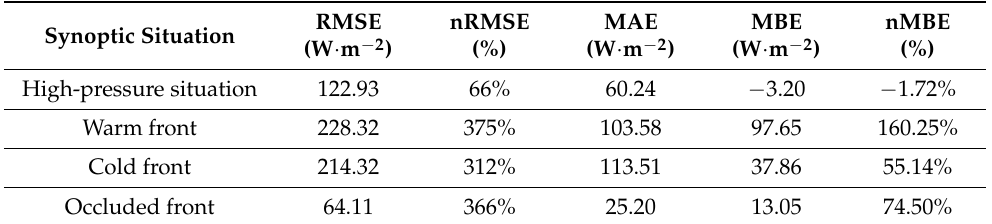
High-pressure situation